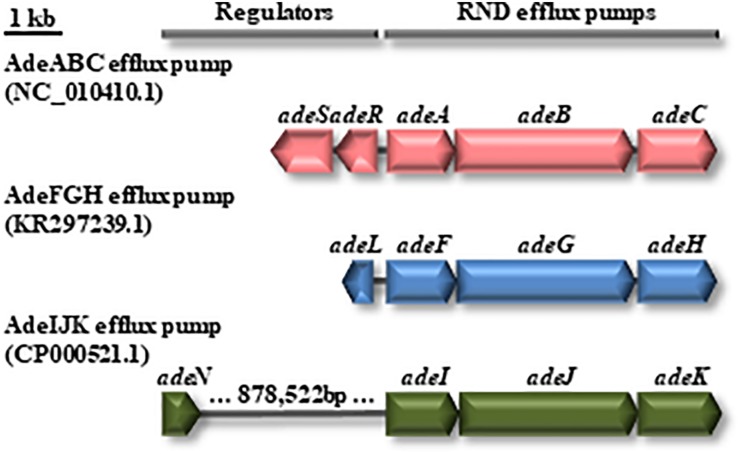
Genetic organization of the AdeFGH, AdeFGH and AdeIJK RND efflux pumps and their regulatory genes. Reference sequences: adeABC and adeRS, NC_010410.1 (coordinates 1883328-1891105); adeFGH and adeL, KR297239.1; adeIJK and adeN, CP000521.1 (coordinates 3171871-3177761 to 2292697-2293350).